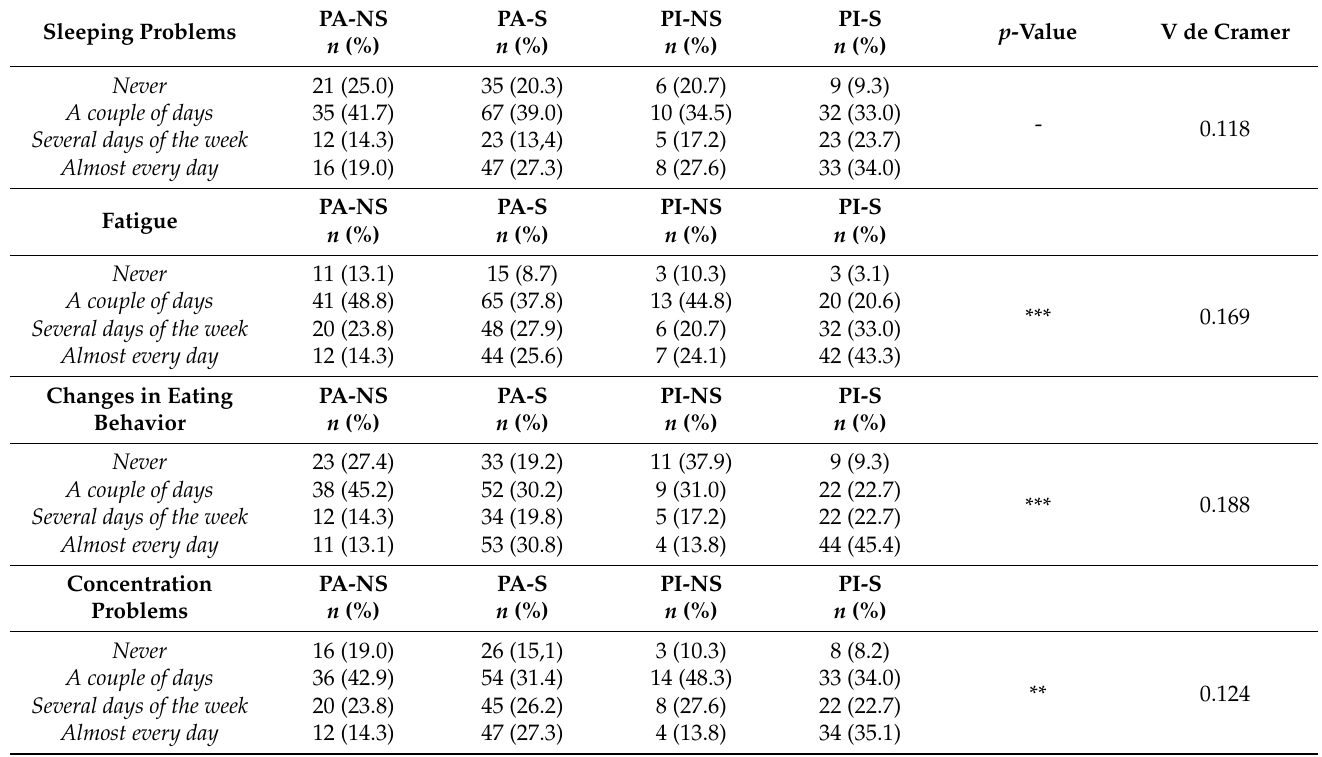
Table 3. Mental health symptoms according to the physical activity profile and sedentary